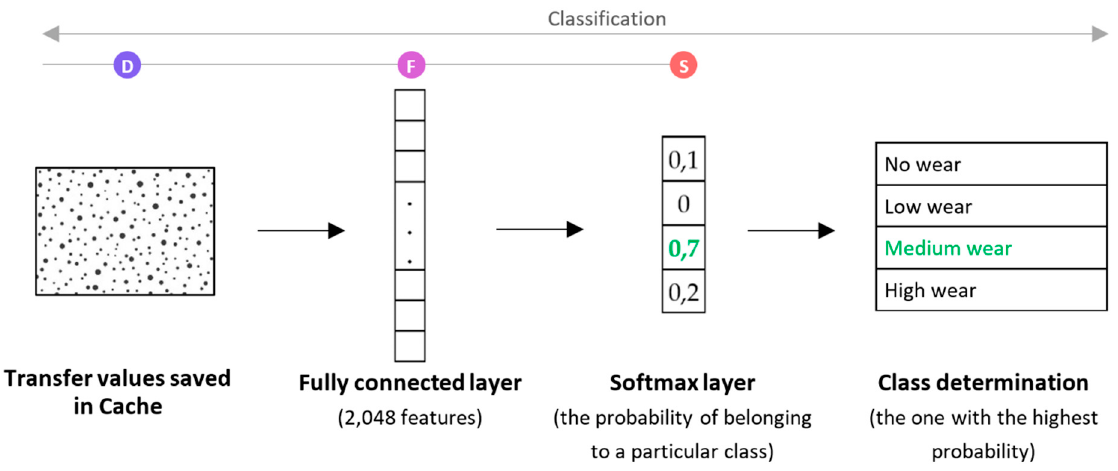
Figure 9. Last layers of CNN that are trained for a specific case.